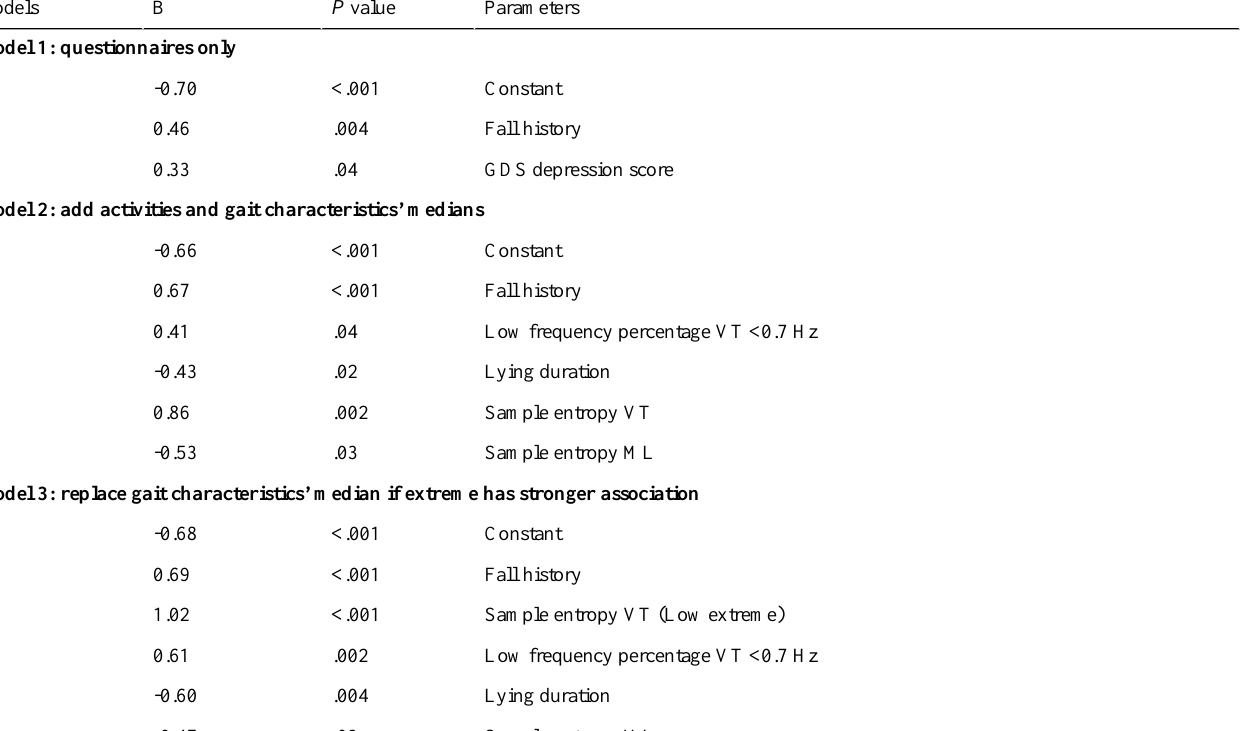
Table 4. Fall prediction models with parameter coefficients and P